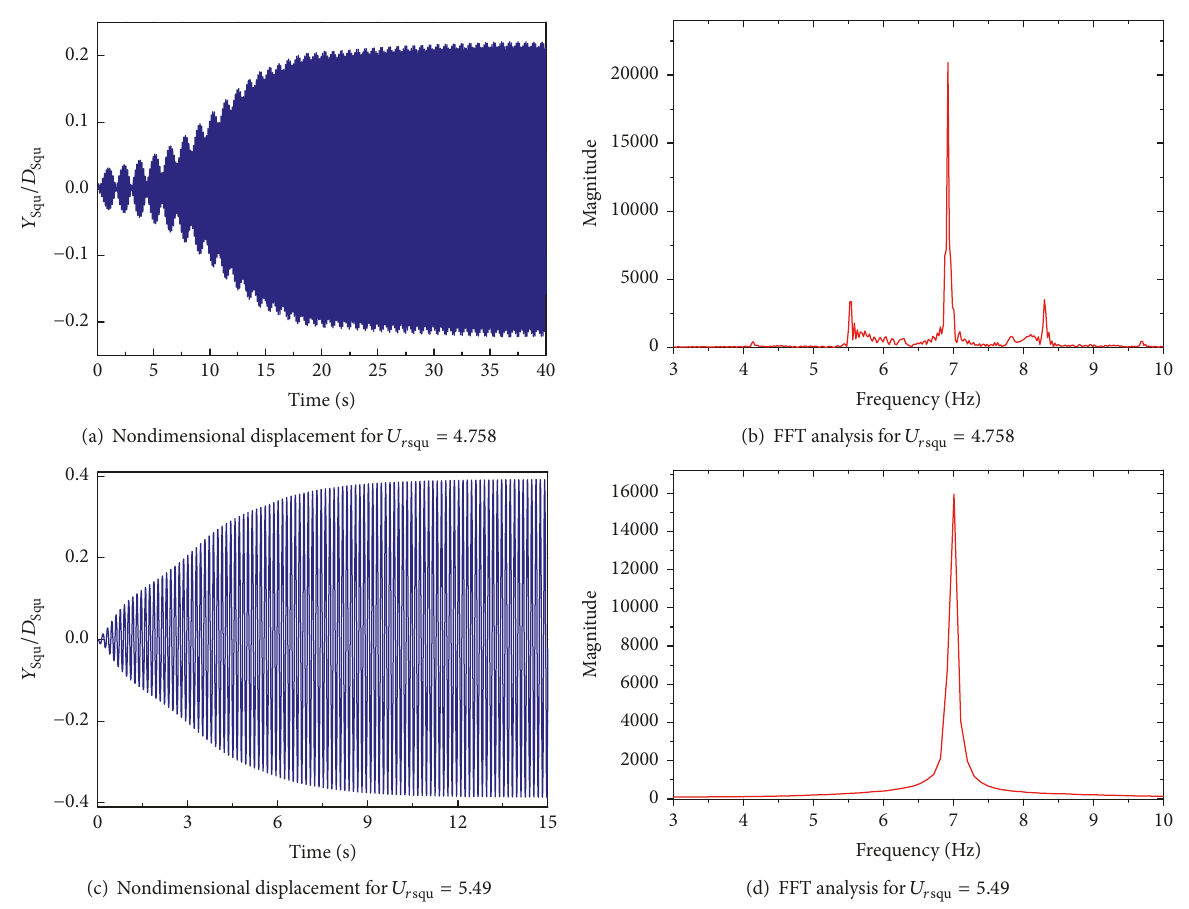
Figure 9: Displacement time-history and FFT analysis results for 𝛼 = 60 ∘